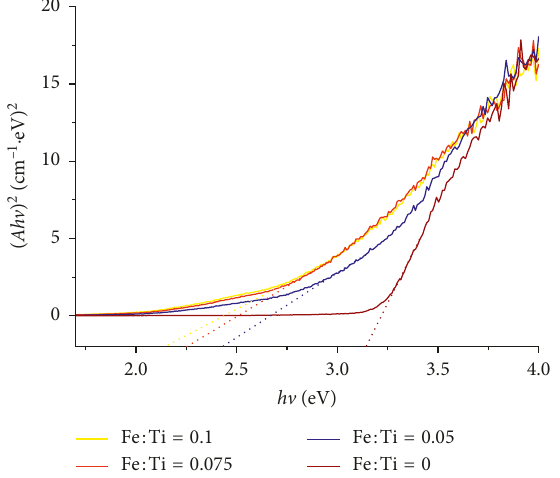
Figure 11: Tauc plot analysis of bare TiO